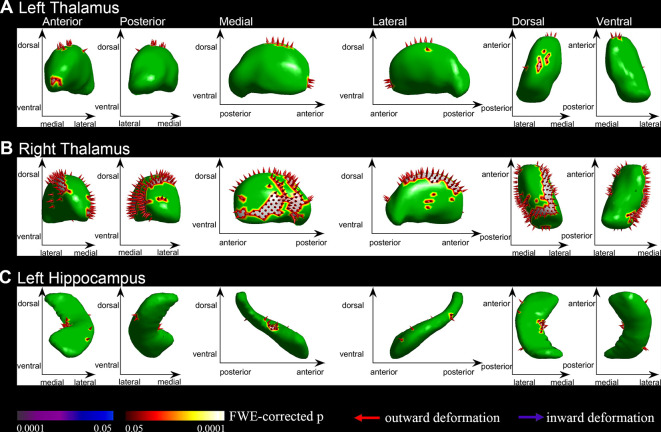
Vertex-wise shape analysis between premature ejaculation (PE) patients and normal controls (NCs). (A) Outward shape deformations (expansions) in the left thalamus. (B) Outward shape deformations (expansions) in right thalamus. (C) Outward shape deformations (expansions) in the left hippocampus. FWE-corrected, p < 0.05.